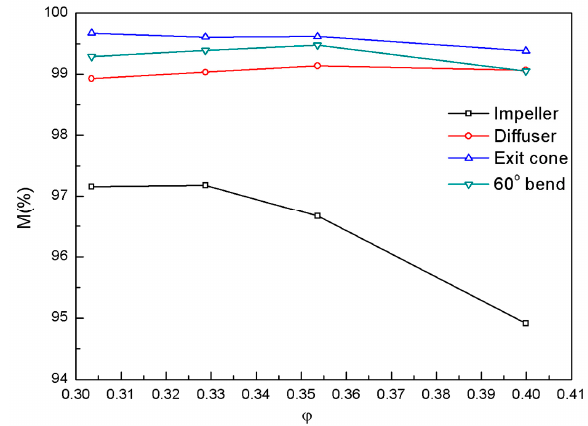
. S D (cid:48) of a component